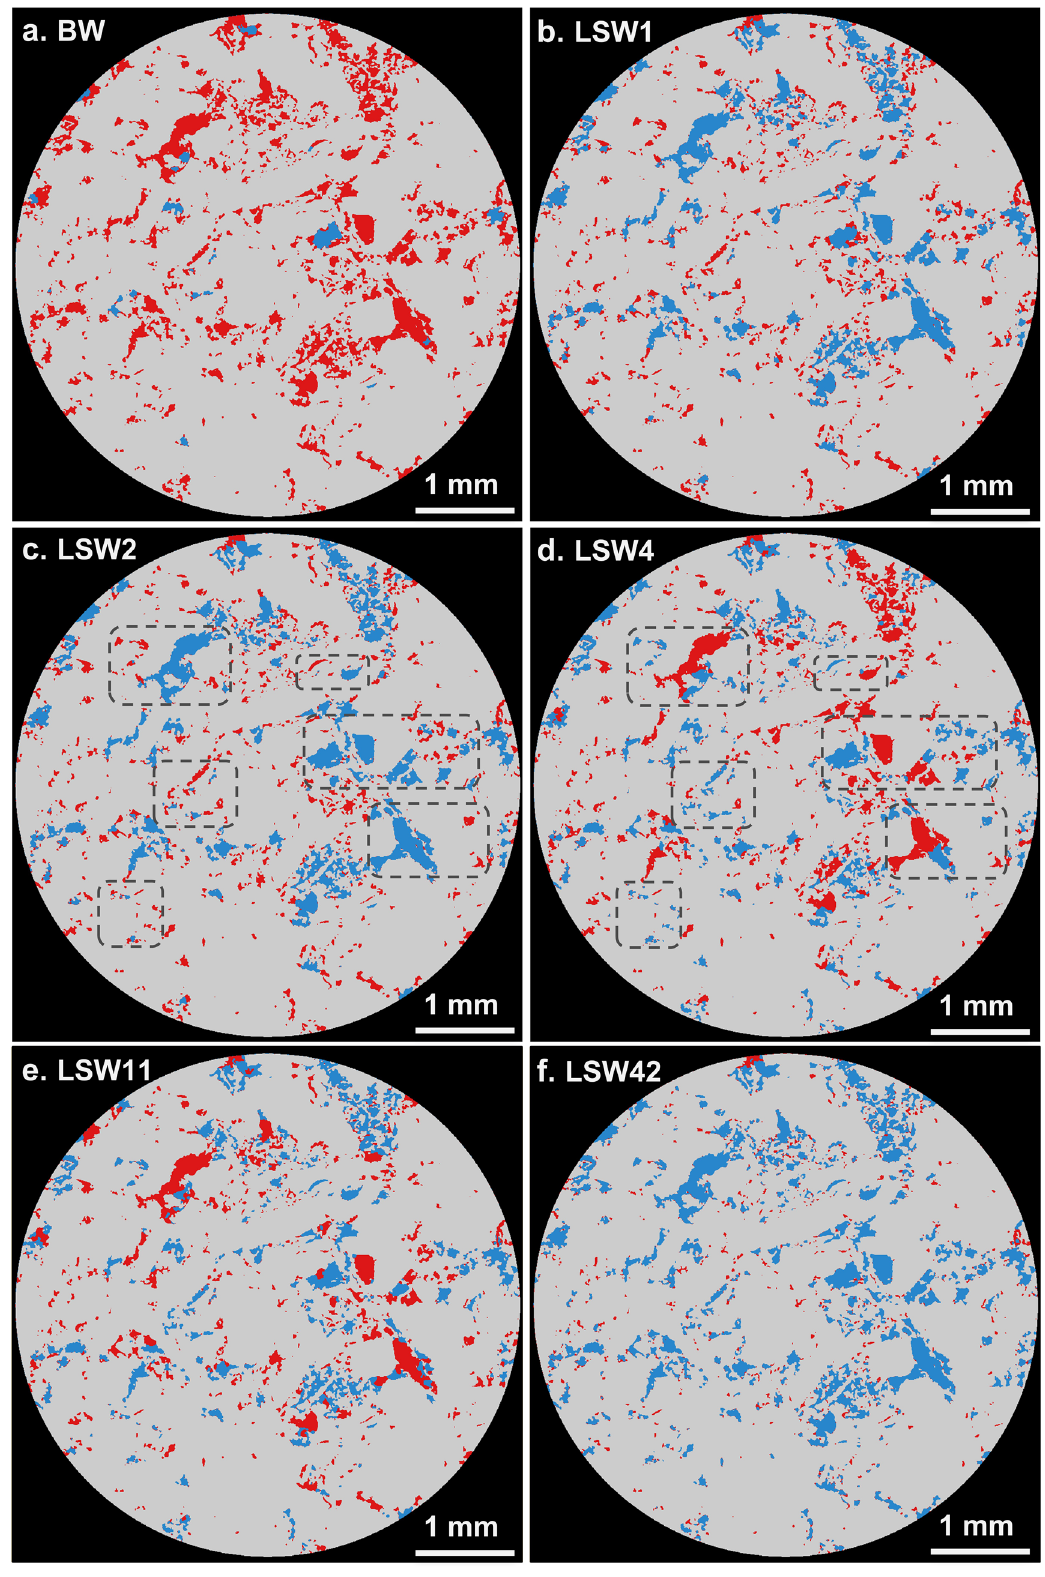
Figure 1. Two dimensional cross-sectional views of the segmented three-dimensional images of oil (red), brine (blue) and rock phase (grey). ( a ) Before waterflooding (BW) oil occupied most of the pore space with a saturation of 88%. ( b,c ) After the first two floods, at 1 and 2 µL/min, low salinity brine mainly invaded larger pores. ( d,e ) After the intermediate floods, 4 and 11 µL/min, fluid redistribution was observed. The highlighted areas show displacement of oil from small pores, with larger pores reoccupied by oil as more pore volumes of brine were injected at higher flow rates. ( f ) After the last flood, 42 µL/min, brine displaced most of the remaining oil. The 3D pore-scale images were segmented and visualized using Avizo 9.5 sofware (https:// www. fei. com/ softw are/ amira-